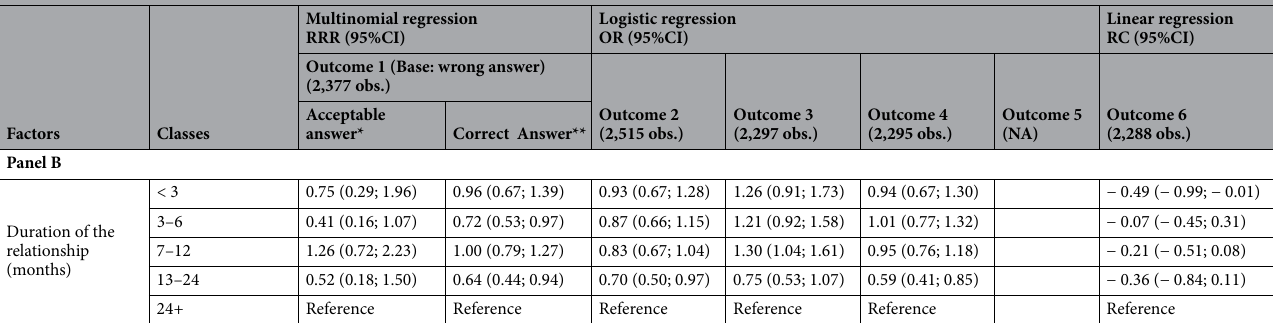
Table 5. Multiple logistic, multinomial and linear regression analysis. Relative risk ratio (RRR), odds ratio (OR) and regression coefficients (RC); 95% confidence interval (95%CI). Results weighted for sex and age to make